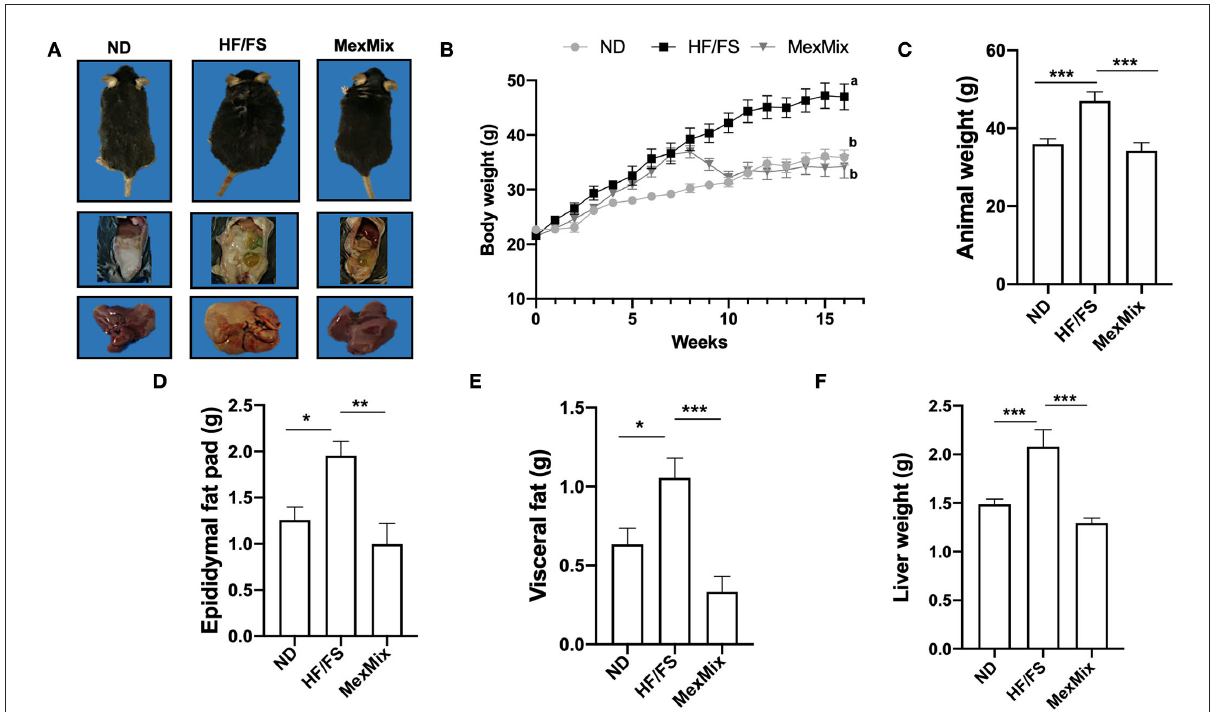
FIGURE1 Effect of MexMix on the body and liver weight and fat pads. (A) Representative images of the mice, epididymal fat, and liver from each group. (B) Body weight gain of 16 weeks. (C) Body weight while killing. (D) Epididymal fat pad weight. (E) Visceral fat weight. (F) Liver weight. Data represent mean ± SEM (* p < 0.05; ** p < 0.01; *** p < 0.001). a, b: Differences between groups.